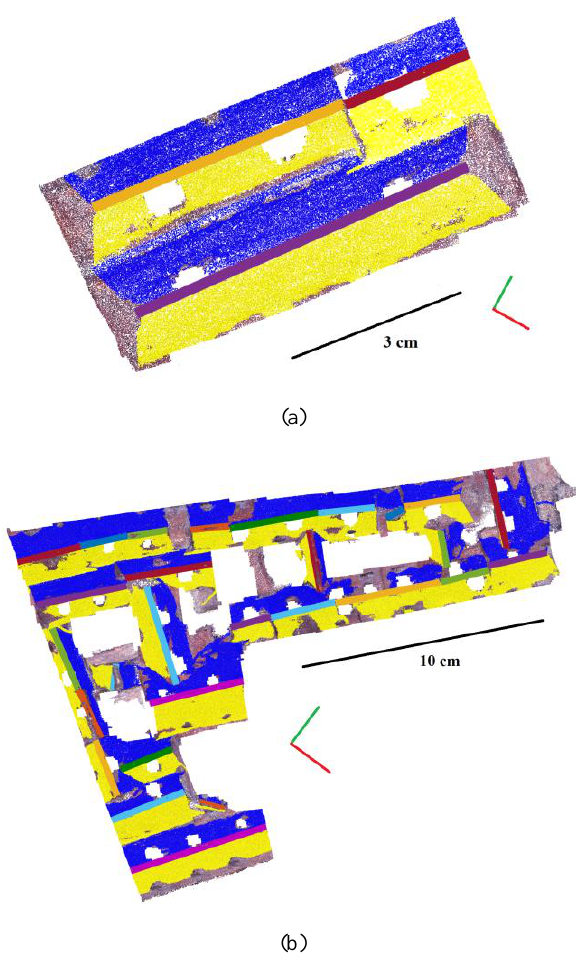
Figure 8. Segmentation of ridges and facets of roofs (top view): (a) block 5; (b) block